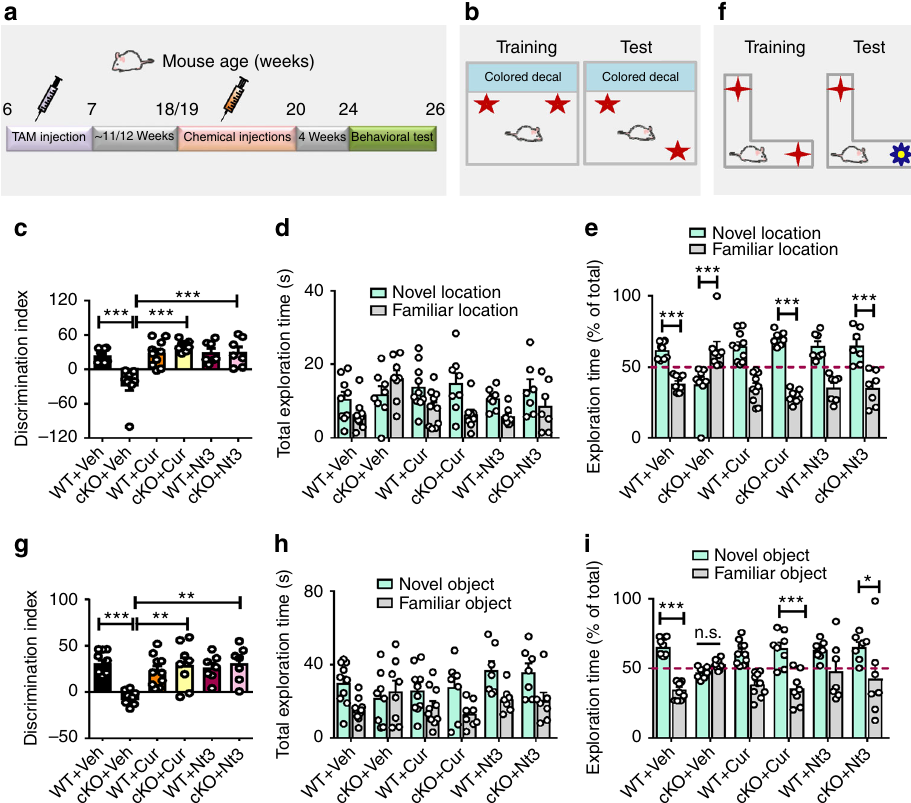
Fig. 9 Rebalancing histone acetylation rescues cognitive de fi cits in 6-month-old Fmr1 cKO;Cre;Ai14 mice. a Experimental scheme for assessing cognitive functions in mice and Cre;Ai14 control mice, followed by TAM injection and various chemical treatments. b – e Curcumin or Nutlin-3 treatment rescues spatial learning de fi cits in Fmr1 cKO;Cre;Ai14 as mice determined by novel location test ( n = 7 to 10 mice per group). Total exploration time ( d ) and percentage exploration time ( e ) of novel location test are shown. f – i Curcumin or Nutlin-3 treatment fully rescues de fi cits in the novel object recognition in Fmr1 cKO;Cre;Ai14 mice ( n = 7 to 10 mice per group). Total exploration time ( h ) and percentage exploration time ( i ) of novel object recognition test are shown. * P < 0.05, ** P < 0.01, *** P < 0.001, n.s.: no signi fi cant difference. Two-way ANOVA was used for all data analyses. Data are presented as mean ± s.e.m.